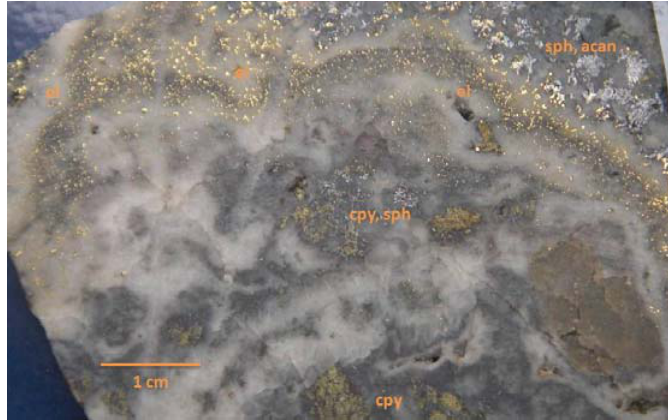
Figure 9. Photograph of electrum-silica only depositional event apparently formed by aggregation of electrum and silica colloids, from the Sunnyside mine, Silverton, Colorado (author’s sample). Abbreviations: el = electrum; sph = sphalerite; acan = acanthite; cpy = chalcopyrite.